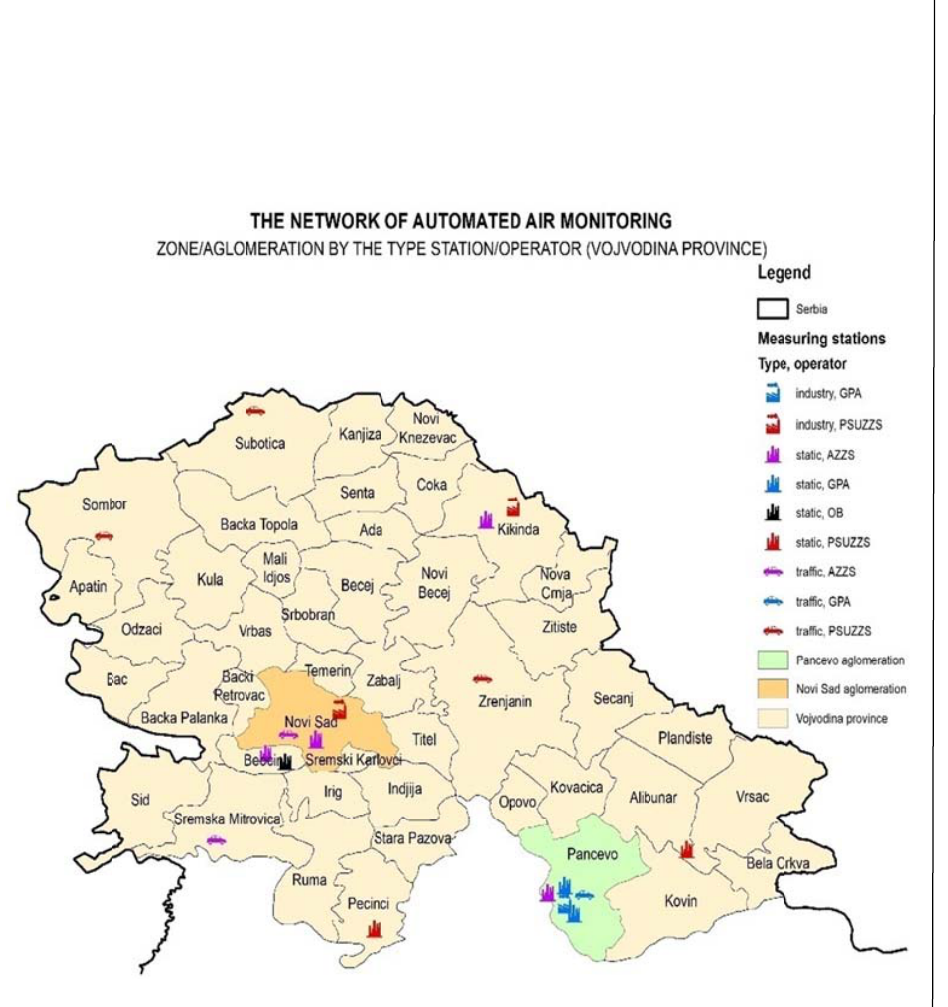
Figure 7 – station an Рис . 7 – С типу ст Слика 7 типу